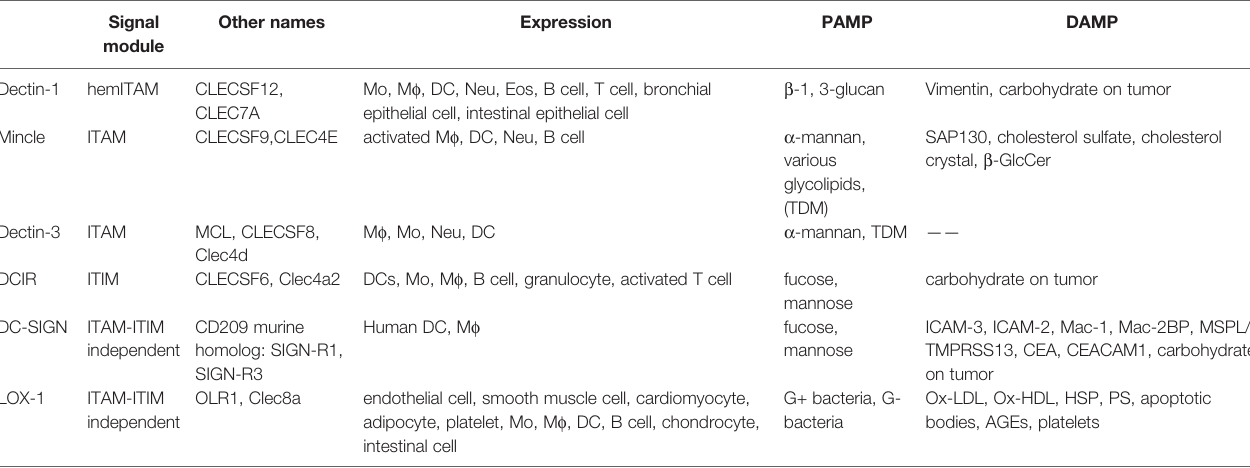
TABLE 1 | C-type lectin receptors and its immune recognition. Signal